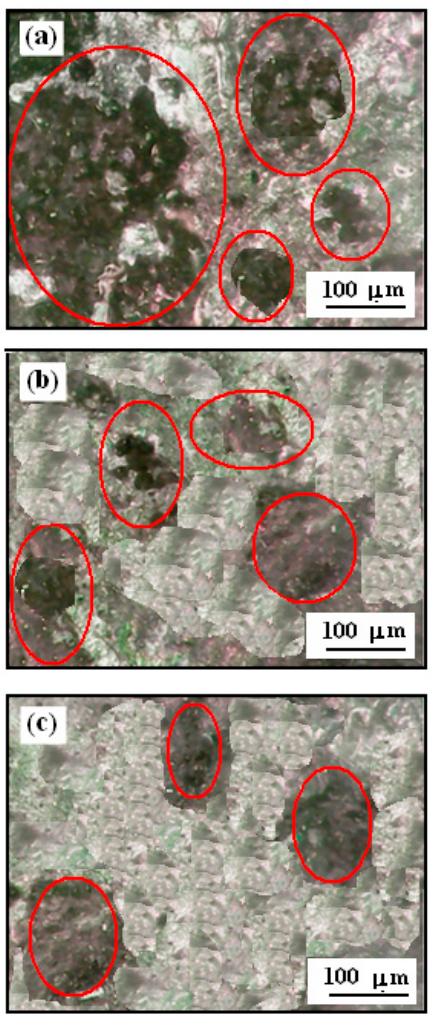
Figure 9. MO images of Inconel 625 coatings onto the S235JR substrate: ( a ) Without, and with coatings produced by laser cladding method with the use of ( b ) Wire, and ( c ) Powder, after corrosion test in 1.2 M Cl − , pH 1.5. Exposure time was five hours. Corrosion pits are marked in red.